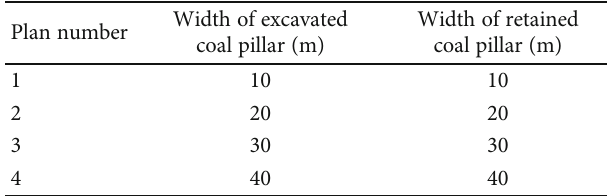
Table 1: Parameters of each scheme. Plan